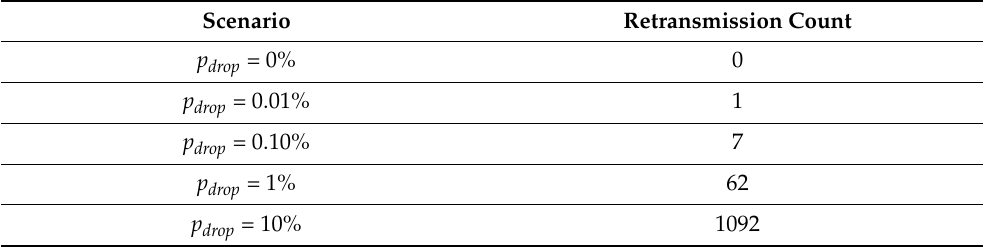
Table 5. FTP Server: Retransmission Count for Five Selected